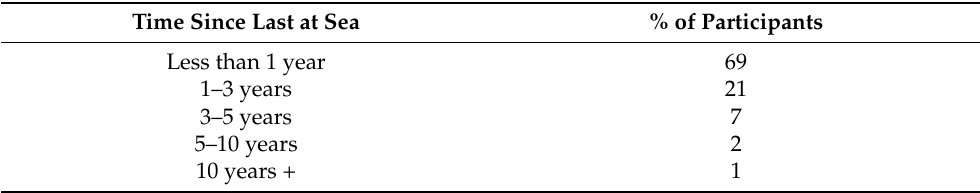
Table 3. Time since last at sea on a Collins Class Submarine. Time Since Last at